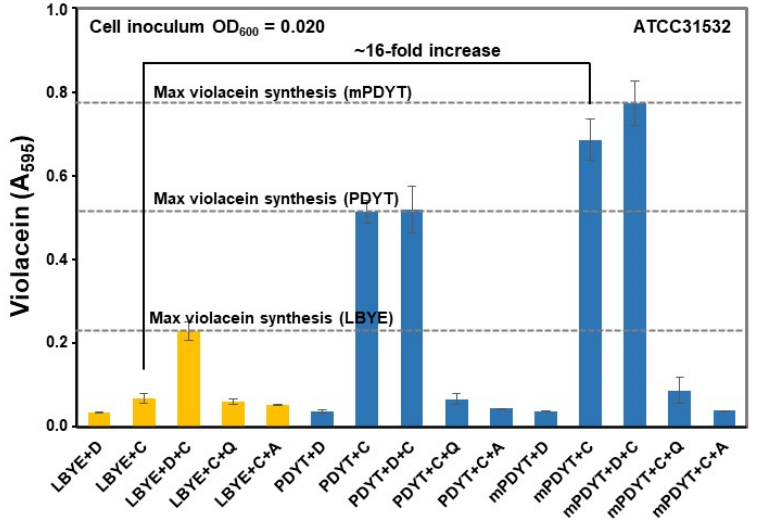
Figure 2. Violacein production of ATCC31532 in LBYE, PDYT and mPDYT in 96-well plates with/without 2% ( v / v ) DMSO. Each growth medium was inoculated with colonies grown on LBA at initial cell densities OD 600 = 0.02. Violacein production was monitored at 595 nm. D, DMSO; LBYE/PDYT/mPDYT+D, growth media with DMSO (D) or C. violaceum cells (C). Azithromycin (A) and quercetin (Q) represent bactericidal and anti-QS controls, respectively, which were used at a 400 µM concentration. Error bars ± SD ( n = 3–4). Grid lines, maximal violacein yields under the indicated conditions.